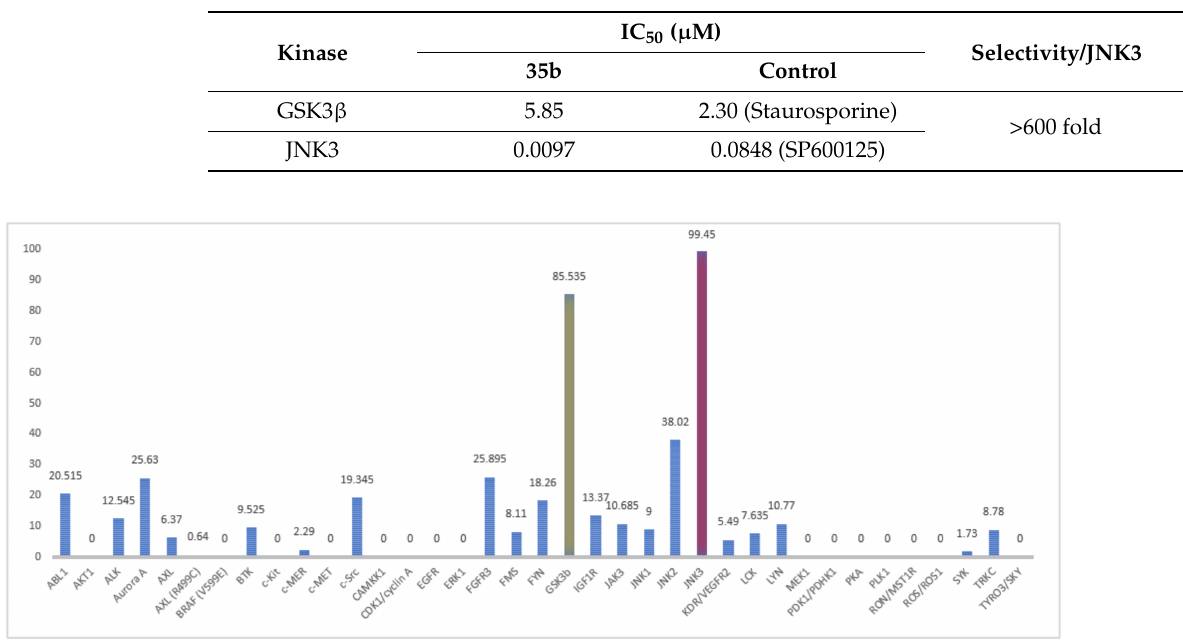
Figure 4. Percentages of enzymatic inhibition exerted by 1 µ M of 35b on 38 selected protein kinases 24